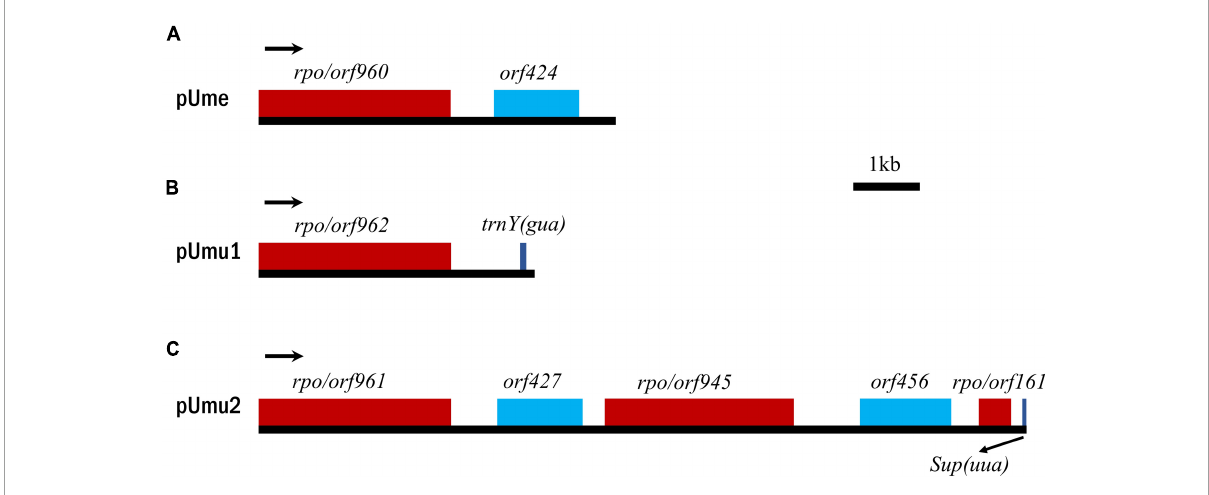
FIGURE3 Comparison of gene maps of circular plasmids. (A) Circular plasmid (pUme) in U. meridionalis . (B,C) Two putative plasmids (pUmu1 and pUmu2) in U. mutabilis . Arrows indicate the direction of gene